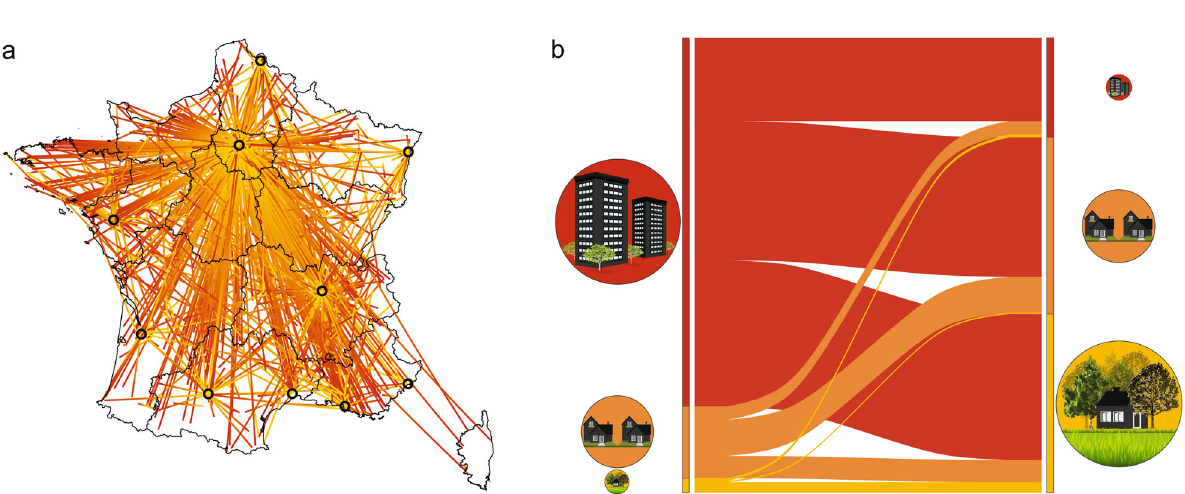
Fig. 2 Population movements during the hours preceding the lockdown. Part a represents the distance between the usual residence and the lockdown residence. The yellow part of the line represents the departure, the red part the arrival. Part b represents the change of residence type before the lockdown in percentage. The left part represents the usual residence and the right part the lockdown